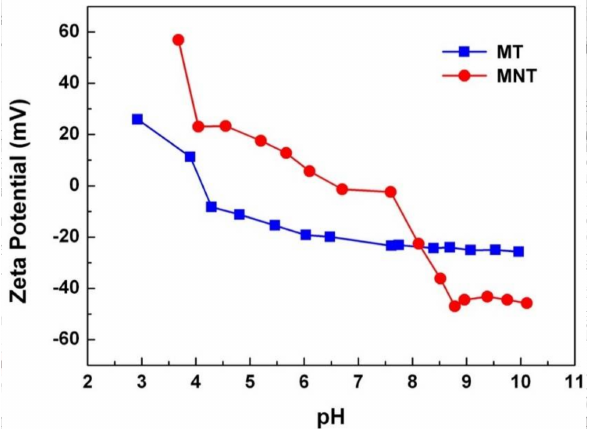
Figure 7. The Zeta potential of MNT and MT